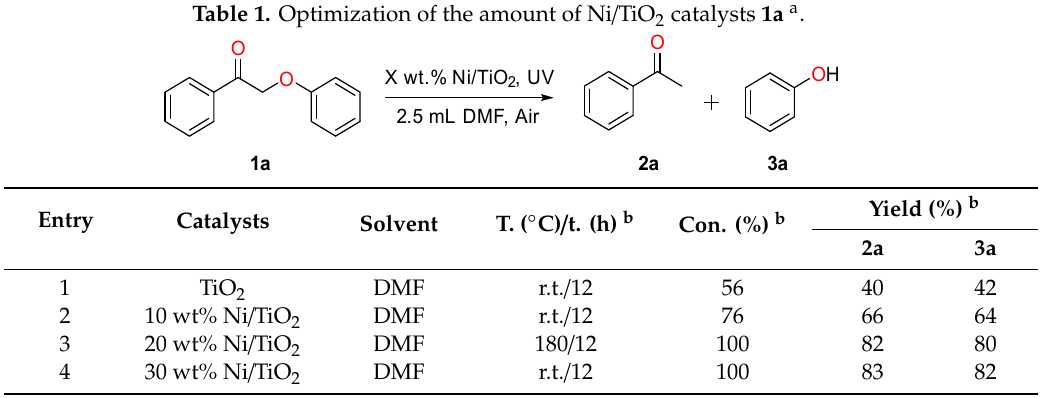
Figure 3. XPS spectra of the Ni 2p for 20 wt.% Ni/TiO 2 ( i ), and Ti 2p for the 20 wt.% Ni/TiO 2 ( ii ) and 20 wt.% Ni/TiO 2 ( iii ).